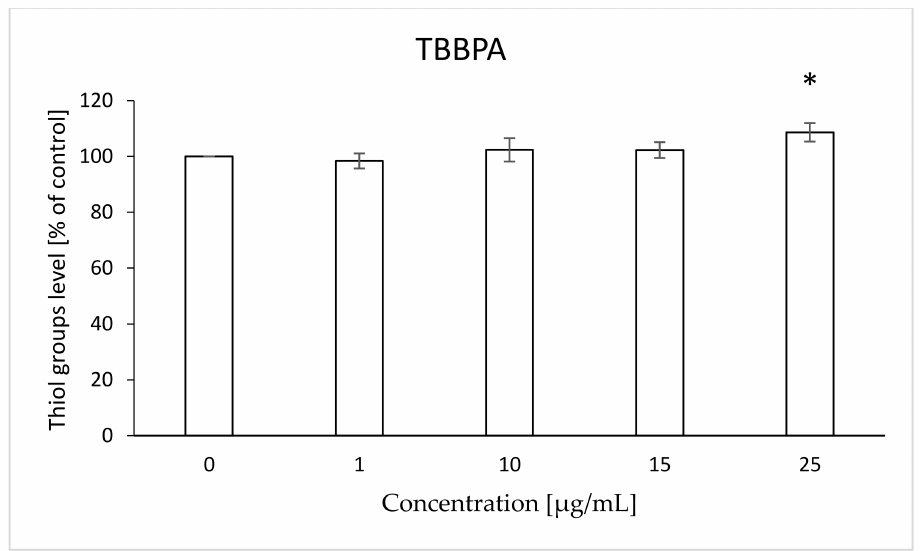
Figure 3. Changes in the thiol groups level in human control erythrocytes and the erythrocytes incubated with TBBPA at 1 to 25 µ g/mL for 12 h. (*) Significantly different from control ( p < 0.05).